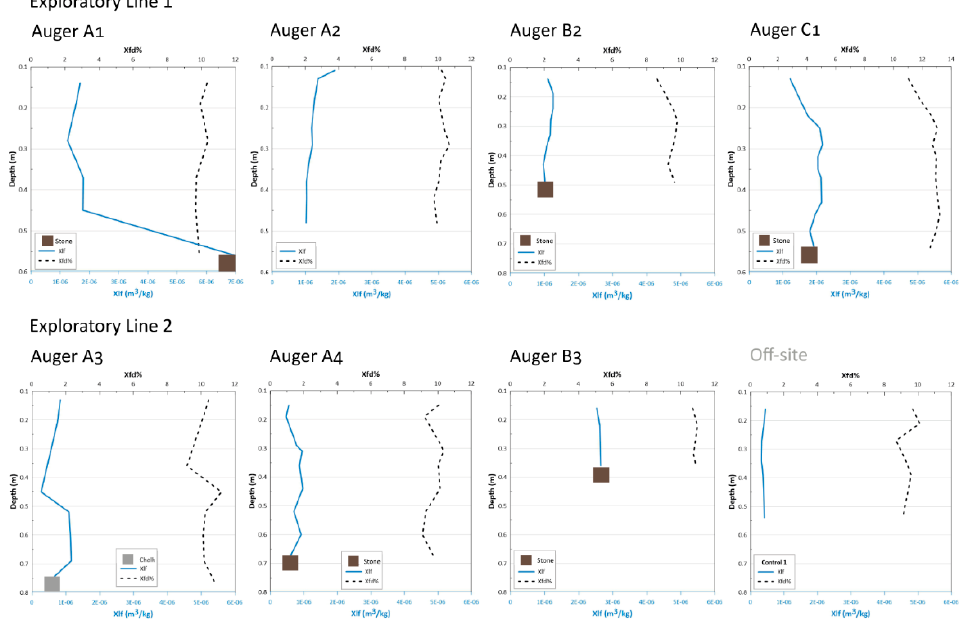
Figure 10. In-depth results of the low-frequency magnetic susceptibility ( χ lf) and frequency-dependent susceptibility of the ‘auger’ samples and off-site controls at Perdika II. The location of the auger points in each exploratory line is shown in Figure 9. The squares indicate the solid materials reached with the augers.